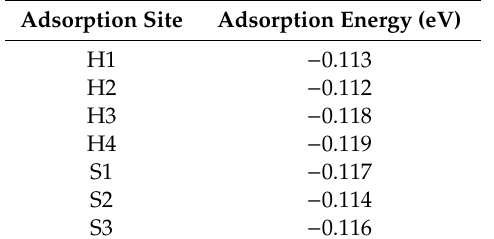
Figure 4. Schematic view of H 2 S interacting with graphene sheet in seven adsorption configurations. Table 2. Calculated adsorption energies of H 2 S on pristine graphene at the different adsorbed sites shown in Figure 4.